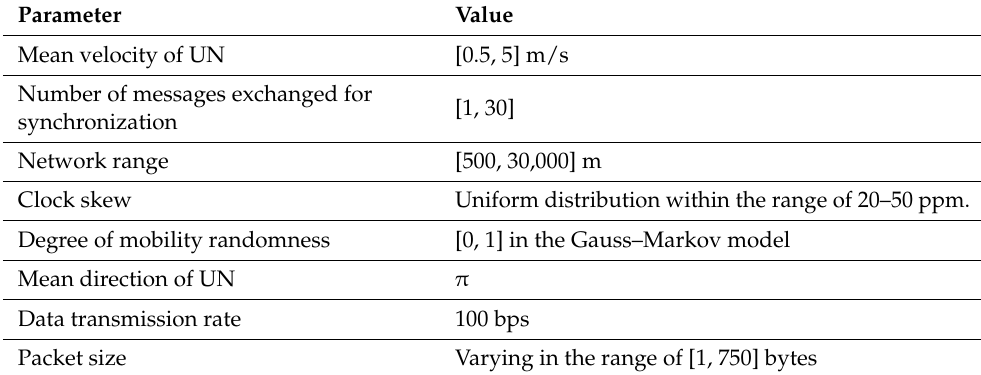
Table 2. Simulation